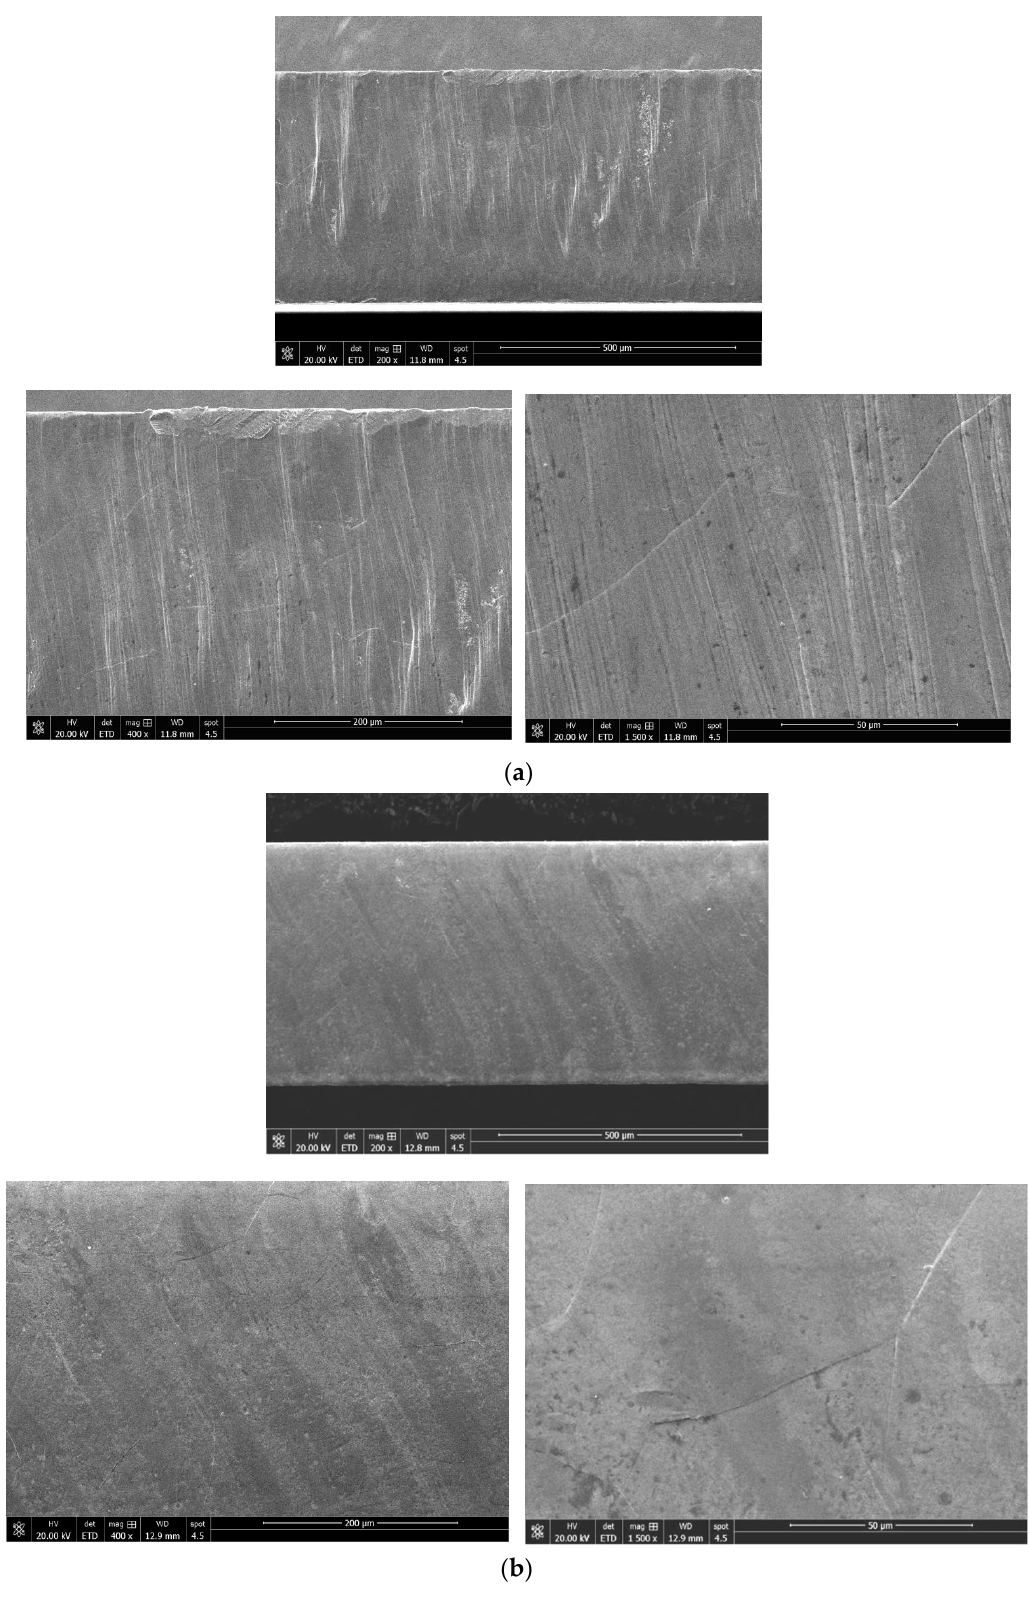
Figure 7. Scanning electron micrographs of cut edges for laser cutting with different magnification times. ( a ) No. 7 sample manufactured using laser cutting; ( b ) No. 21 sample manufactured using laser cutting.